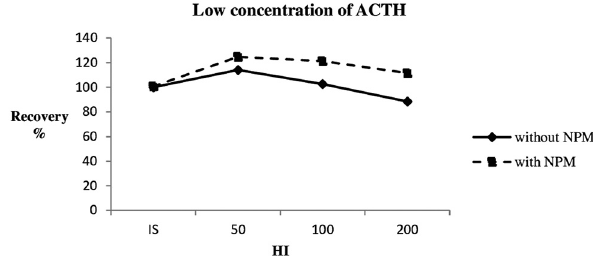
Figure 1: Low concentration of ACTH recovery graphic between without NPM and with NPM groups. ACTH concentration